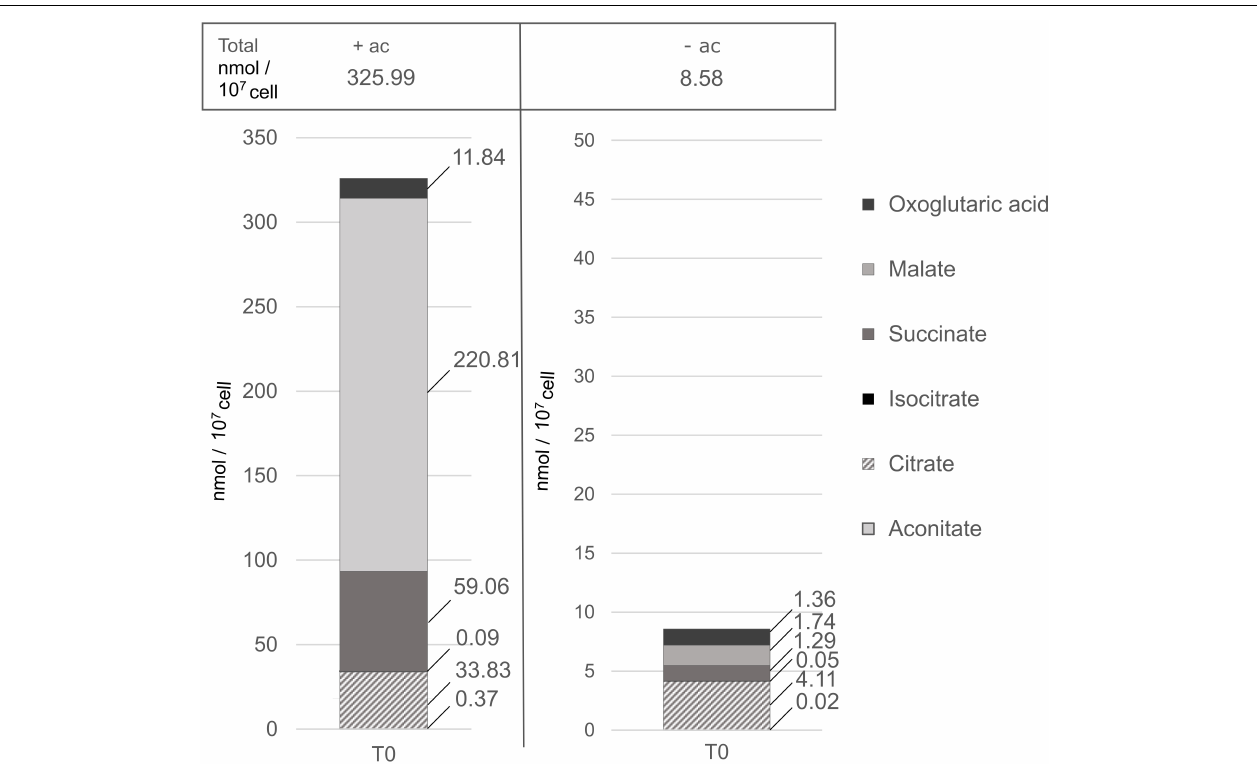
FIGURE 7 | Piled histograms showing the composition in TCA and glyoxylate cycle intermediates (in nmol/10 7 cell), grown with acetate (+ac) or without (–ac) before the light treatment. 2OG, oxoglutaric acid; MAL, malate; SUCC, succinate; ICIT, isocitrate; CIT, citrate; ACON, aconitate. There are four replicates per metabolite per medium. Acetate has a significant influence on TCA and glyoxylate intermediates accumulation ( p -value < 0.001), specifically on malate and succinate accumulation ( p -value < 1.4 × 10 − 7